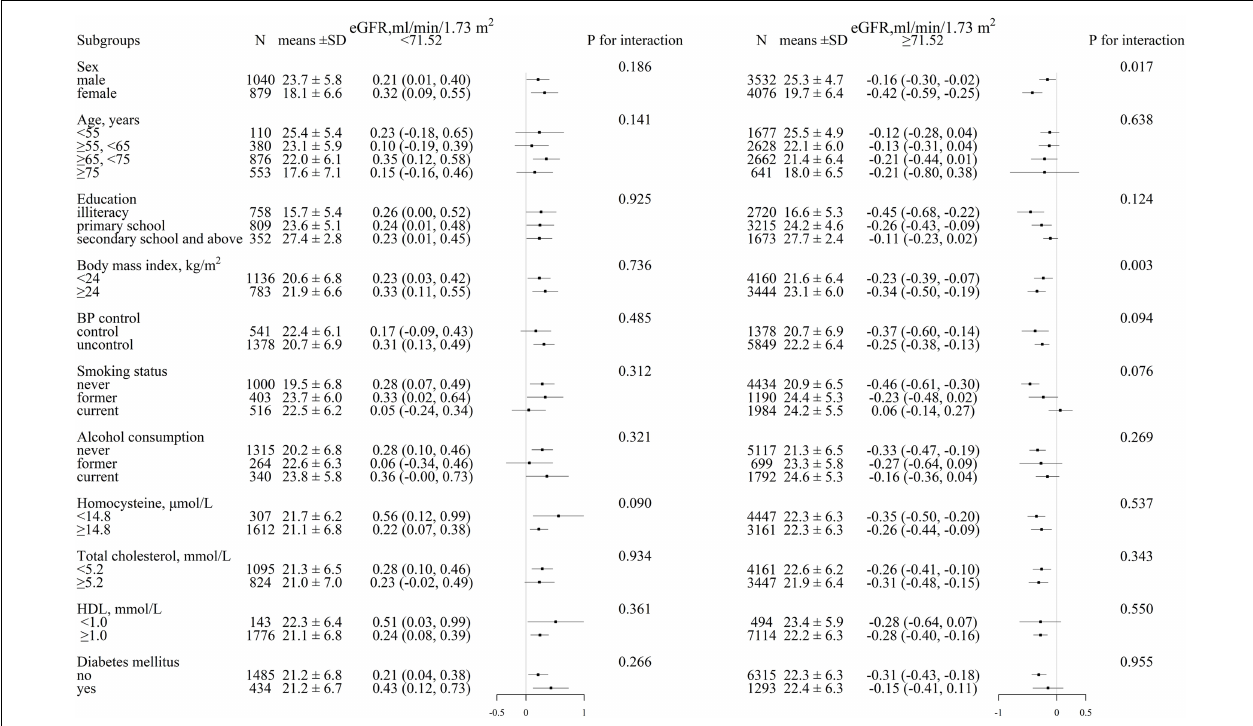
FIGURE 3 | Stratified analysis for MMSE and eGFR in various subgroups divided by 71.52 ml/min/1.73 m 2 . (eGFR < 71.52 ml/min/1.73 m 2 , eGFR ≥ 71.52 ml/min/1.73 m 2 )*. Each black square represents the effect size of the study together with the 95% CI. Each subgroup analysis adjusted for sex, age, body mass index, systolic blood pressure, diastolic blood pressure, education, coronary heart disease, diabetes mellitus, smoking status, alcohol consumption, homocysteine, total cholesterol, triglycerides, high-density lipoprotein, and antihypertensive drugs, except for the stratification variable.